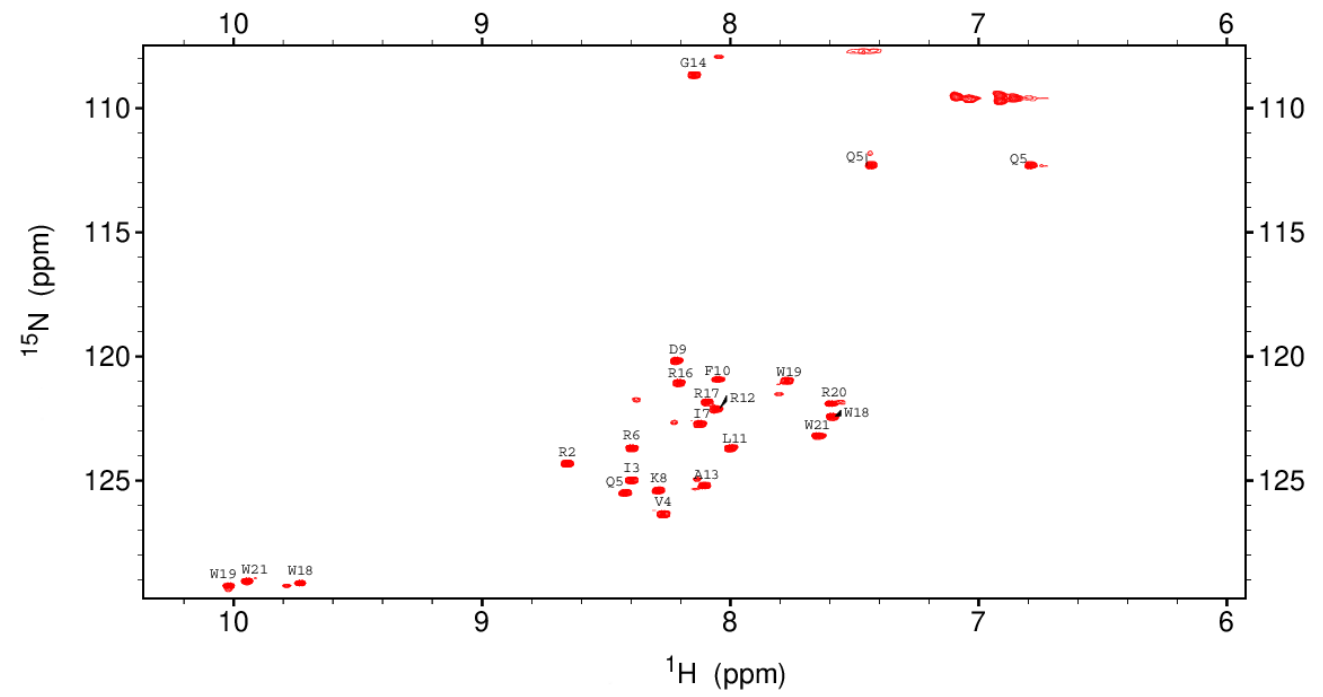
Figure 8. 1 H- 15 N HSQC spectra of 0.6 mM rKR12AGPWR6 in 20 mM sodium phosphate Figure 8 . 1 H- 15 N HSQC spectra of 0.6 mM rKR12AGPWR6 in 20 mM sodium phosphate buffer, pH 4.5, 298 K. The 15 N-labeled samples were expressed in E. coli BL21 (DE3) cells grown in M9 medium containing 15 N-labeled ammonium chloride (1 g/L), and the purification of peptides as mentioned above. The cross peaks of rKR12AGPWR6 were shown in red.